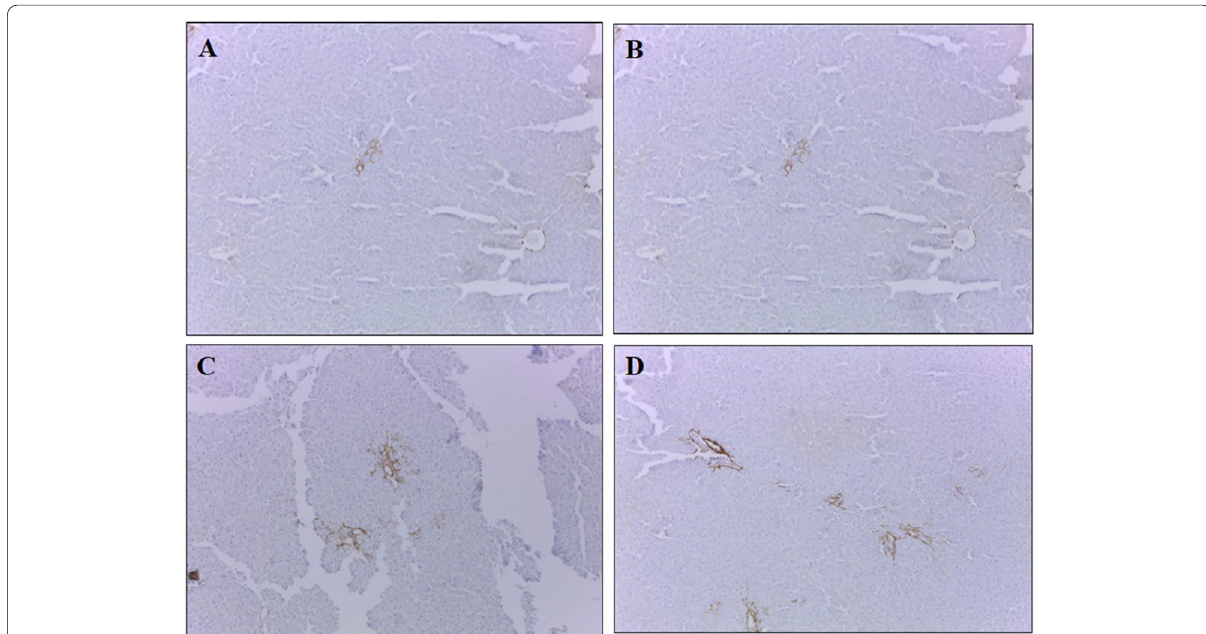
Fig. 5 Immunohistochemical study of COX‑2 in the liver tissue of the control group ( A ), hepatotoxic group ( B ), BM‑MSC‑treated group ( C ), and spontaneous recovery group ( D ) (magnification 40) ×